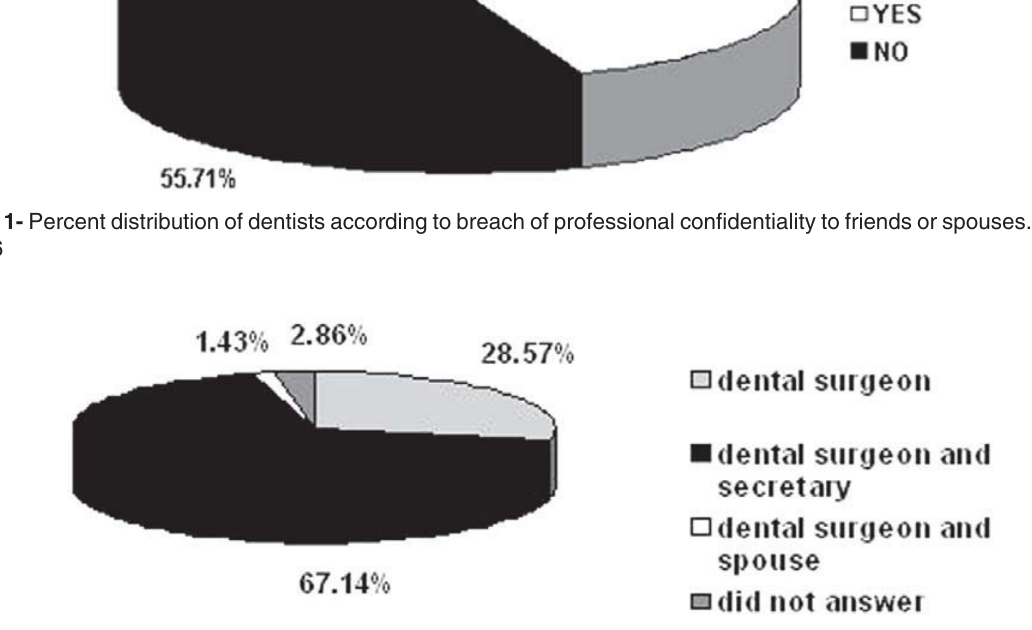
FIGURE 2- Percent distribution of the people with access to the dental records of the patients treated by the interviewed dentists Andradina/SP, 2006